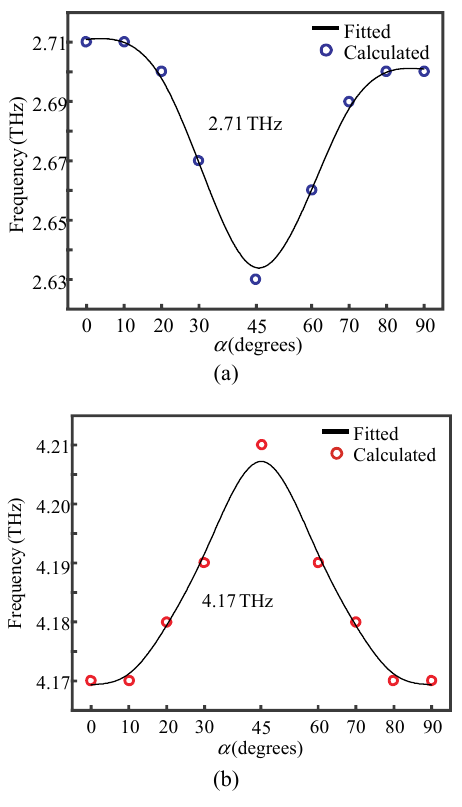
Fig. 8 Shift in frequency as a function of polarization angle α : (a) shift is plotted for a resonant frequency 2.71 THz while in (b) shift is plotted for 4.17 THz. To make the behavior of shifts more visible, a fitted curve is plotted as